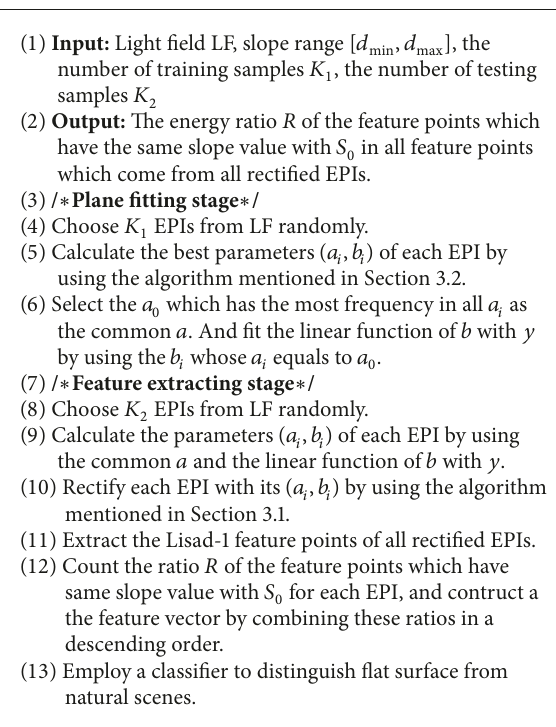
Algorithm 1: The proposed strategy for flat surface